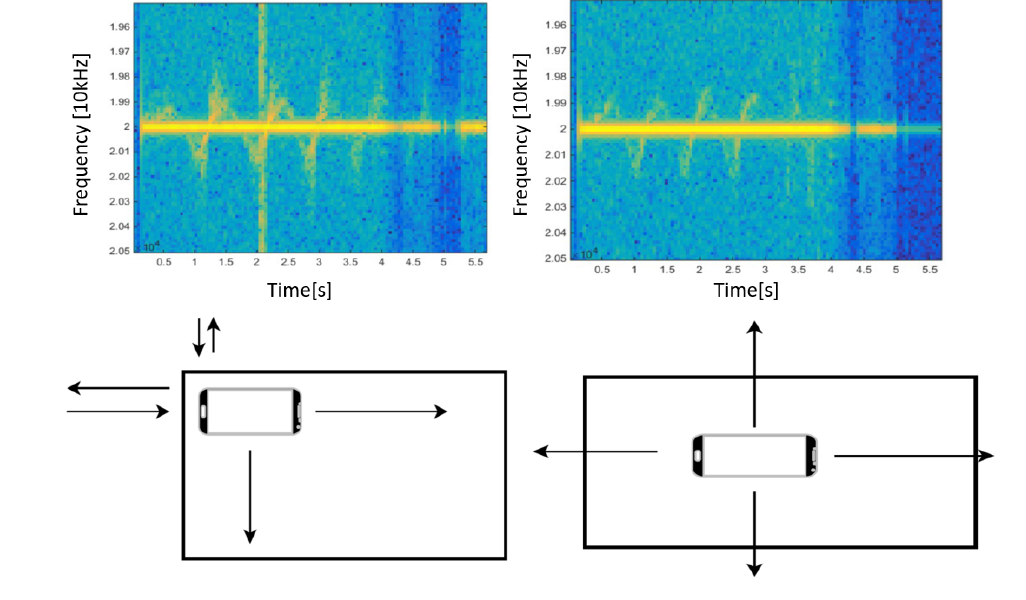
Figure 2. Bottom left shows the placement of the device on the corner of the table and its spectrogram is shown on the top left side. Bottom right : The device was placed in the middle of the table and its corresponding spectrogram is shown on the top right side. The back reflection of the corner placement is stronger due to the multi-path